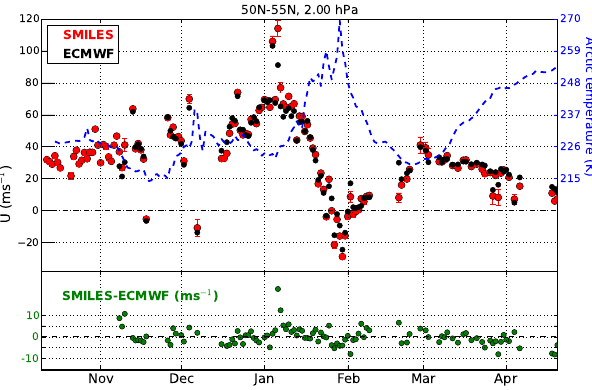
Fig. 11. Upper panel: daily-averaged SMILES zonal-wind in the northern high-latitudes at 2hPa ( ∼ 41km) (red dots) and ECMWF analyses (black dots) between 50–55 ◦ N. SMILES winds are re- trieved from the O 3 line measured in band-B or in band-A if B is not measured. Data with a line-of-sight orientation between ± 10 ◦ from the zonal direction are used. ECMWF winds are projected on the line-of-sight. Temperature information (blue dashed line) is based on daily and zonally averaged MLS measurements between 60–80 ◦ N. Lower panels: difference